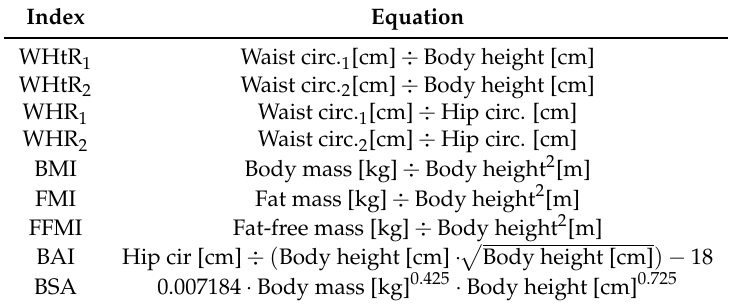
Table 1. Description of somatic indexes.